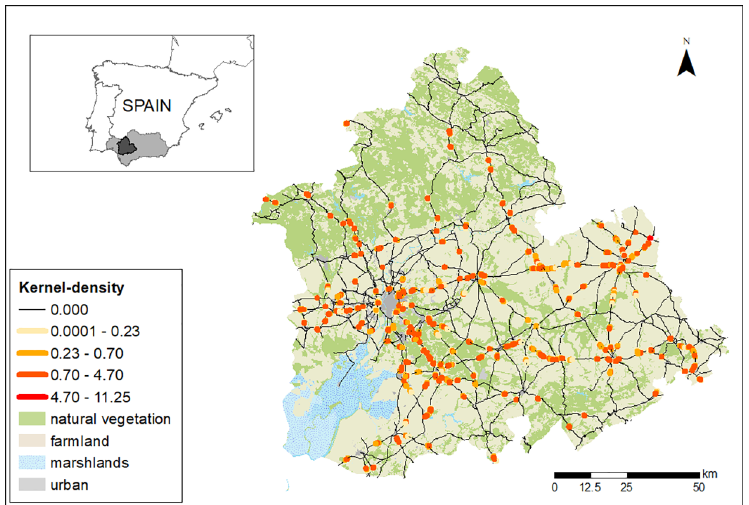
Fig 4. Kernel density estimation of the collision hotpots found in the road network of Seville. The land uses of the area are also shown. We used a bandwidth of 500m as the search radius for calculating the number of accidents, to estimate a density value (Natural Breaks Classification). Estimated densities classified using the Jenks method [44]. The inset map indicates the location of Seville (dark grey area) and Andalusia (light gray area) is